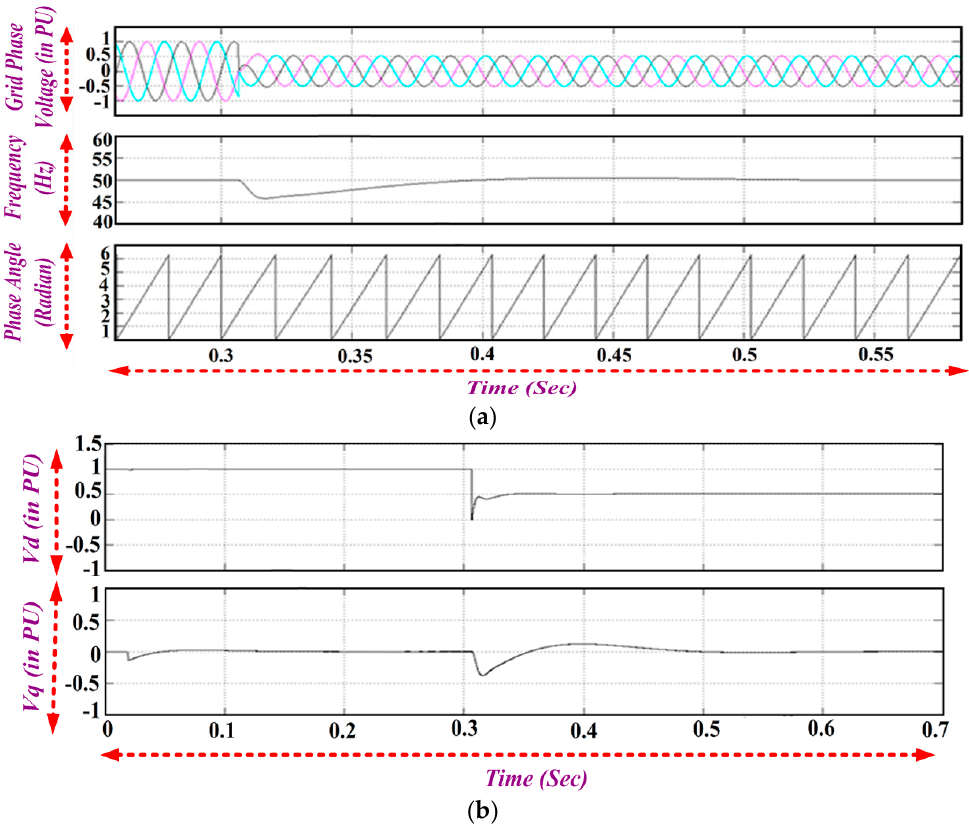
Figure 23. ( a ) Frequency and Phase Detection Variation during Voltage Sag; ( b ) q- axis and d- axis Voltage Magnitude during Voltage Sag.